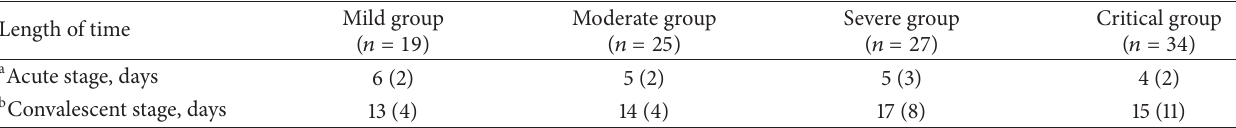
Table 2: Time frame from disease onset to sample collection in patients with HFRS. Length of time